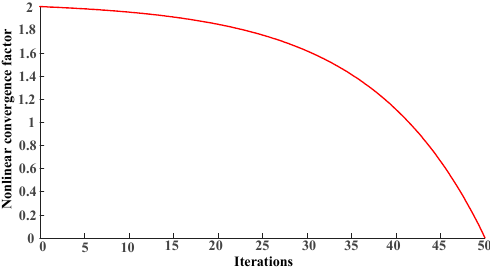
Figure 3. The curve of nonlinear convergence factor.